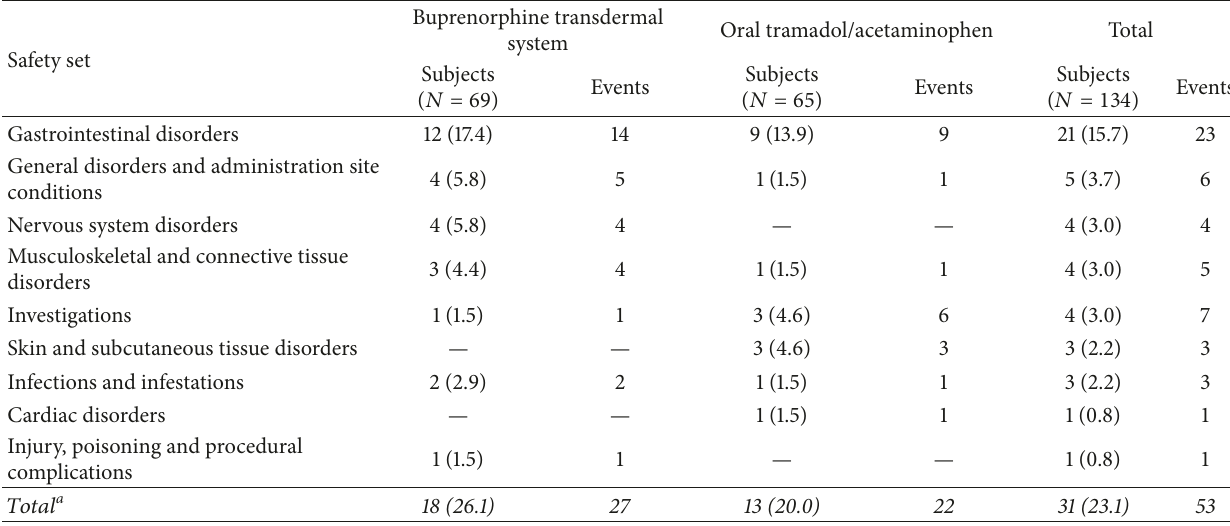
Table 6: Adverse events by system organ